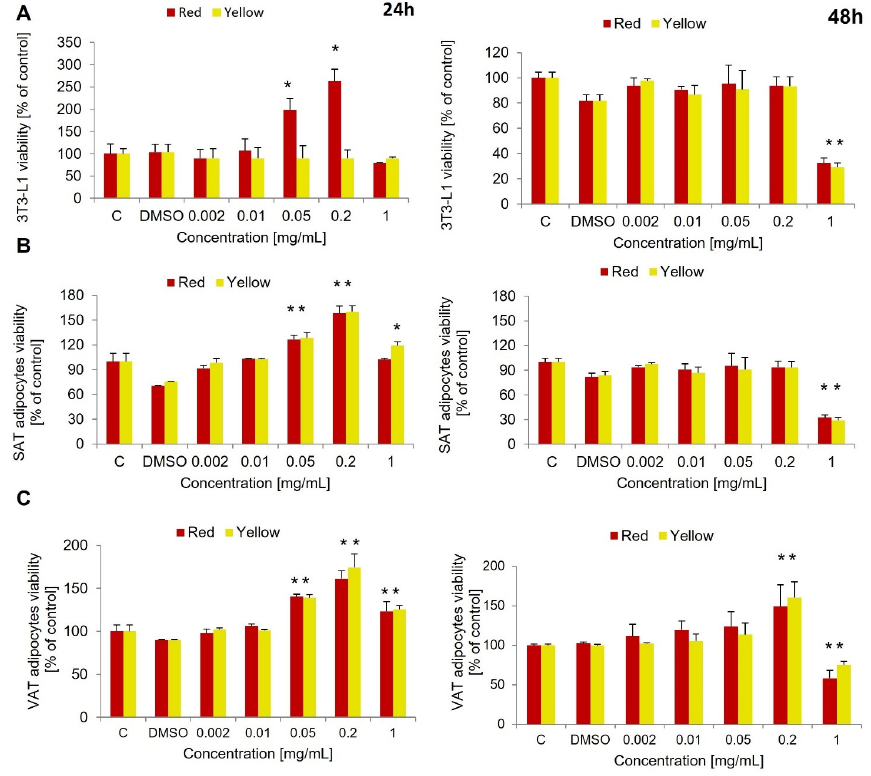
Figure 1. The viability test using 3-(4,5-dimethylthiazol-2-yl)-2,5-diphenyltetrazolium bromide (MTT) for red and yellow Cornus mas (CM) fruit extracts in various ranges of concentration performed after 24 h and 48 h in: ( A ) 3T3-L1 adipocytes, ( B ) SAT-derived human adipocytes (subcutaneous adipose tissue), ( C ) VAT-derived human adipocytes (visceral adipose tissue). DMSO-dimethyl sulfoxide. * p < 0.05, ** p < 0.000. Results have been presented as mean ± SD. 3.3. Glucose Uptake in Insulin-Resistant Adipocytes Treated with Red and Yellow CM Fruits Extracts Insulin resistance in adipocytes was induced with the use of palmitic acid (16:0) at a concentration of 0.5 mM. It has been proven that insulin resistance was successfully in- duced, and no increase in insulin-stimulated glucose uptake (ISGU) was observed in in- sulin-resistant adipocytes (Figure 2A–C). For all analyzed IR adipocytes ISGU was com- parable to baseline glucose uptake and significantly lower than in control adipocytes (3T3L1 p = 0.002, SAT adipocytes p = 0.004, VAT adipocytes p < 0.000). In control cells, an increase in ISGU was observed compared to basal glucose uptake for all of the tested cells (3T3L1 p = 0.001, SAT adipocytes p = 0.003, VAT adipocytes p = 0.009) which proves the proper response of these cells to insulin. In 3T3-L1 insulin-resistant adipocytes, red CM fruit extract increased ISGU ( p = 0.002, Figure 2B) compared to IR cells, which might suggest that red CM fruit extract might have